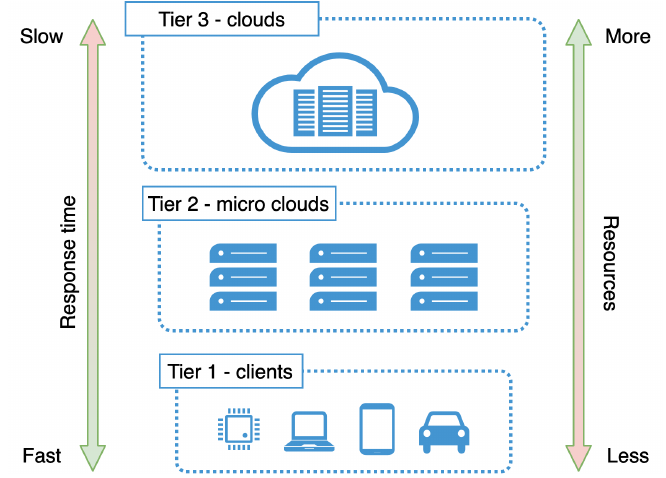
Figure 2. Three-tier architecture, with the response time and resource